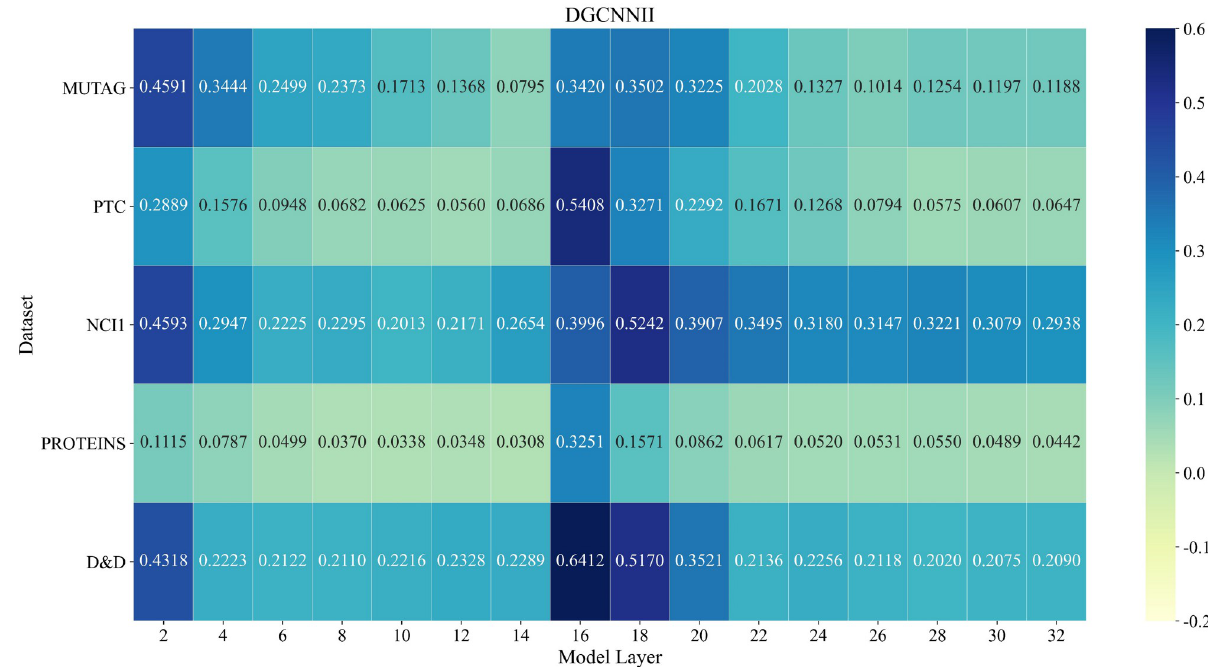
Fig 3. MAD values of different layers of DGCNNII on 5 datasets. Darker color means larger MAD value. We can find that at the output of the first- stage of DGCNNII (layer 16), the MAD value is greatly improved.